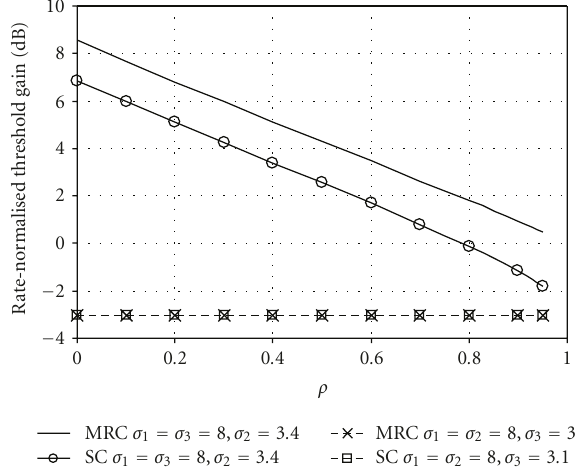
Figure 4: Impact of correlation on the SNR threshold gain of MRC and SC for various lognormal